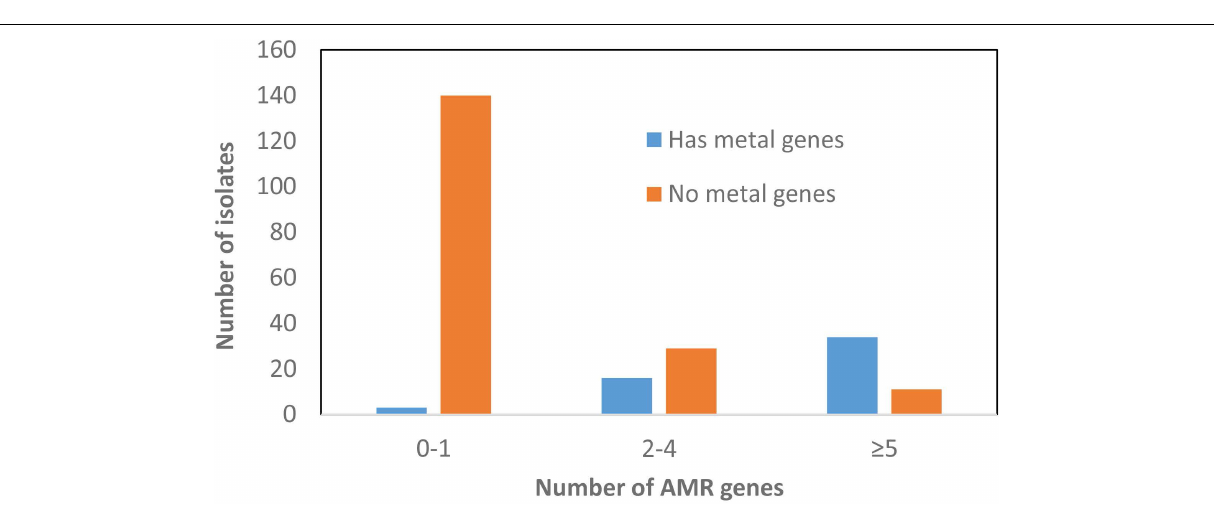
FIGURE 5 | Correlation between presence of antimicrobial resistance genes (ARGs) and heavy metal resistant genes (HMRGs). This depicts information related to plasmids and the presence of these